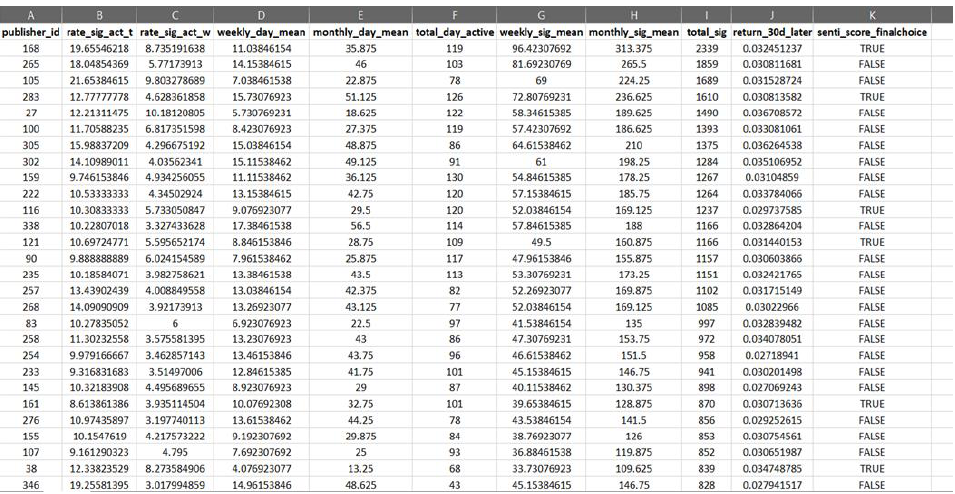
Table 3. Validation variables from review